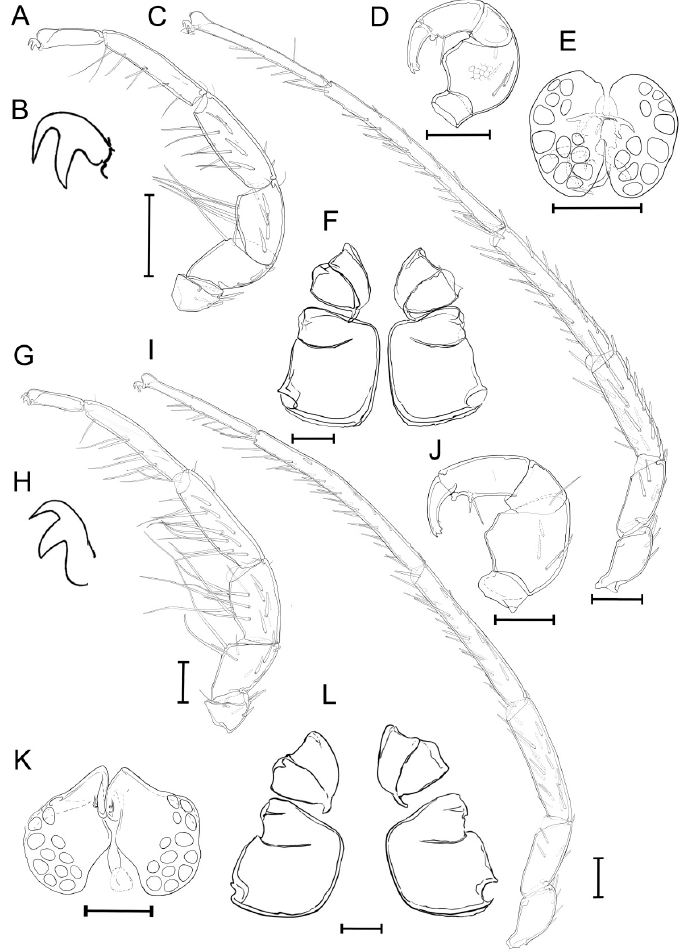
Figure 5. Unionicola ( Myanmaratax ) savadiensis subgen. and sp. nov. The male, slide RMBH Hyd 603: ( A ) I-L, ( B ) claw of I-L, ( C ) IV-L, ( D ) P, ( E ) genital field, and ( F ) coxal plates. The female, slide RMBH Hyd 603: ( G ) I-L, ( H ) claw of I-L, ( I ) IV-L, ( J ) P, ( K ) genital field, and ( L ) coxal plate. Scale bars = 100 μ m. (Graphics: Yulia E. Chapurina). Female morphology. I-L: I-L-1 with one or 2 lateral blunt and one slender setae and 3 dorsal blunt setae (or 4 dorsal setae grouped in two pairs). I-L-2 with 3 lateral blunt setae and 2 lateral slender setae, not serrated, one distal short blunt seta and one distal heavy seta, and 2 ventro-distal long heavy setae. I-L-3 with one row of 4 or 5 lateral blunt setae,